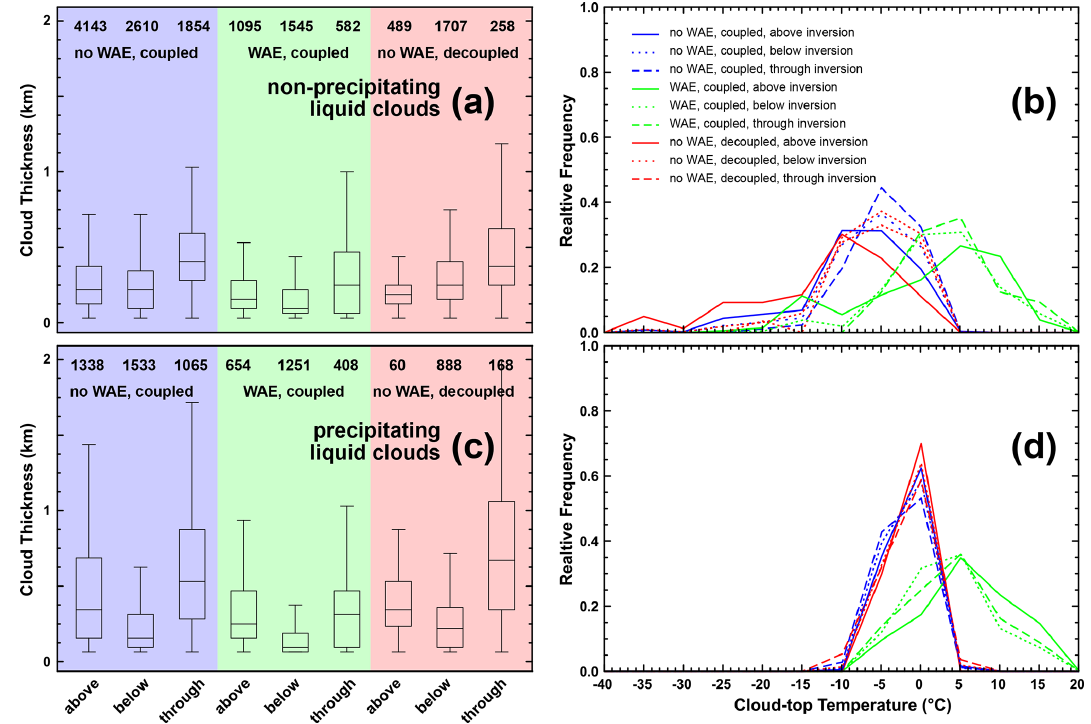
Figure 9. Statistics on the geometrical thickness (a, c) and the frequency distribution of cloud-top temperature (b, d) of non-precipitating (a, b) and precipitating (c, d) liquid clouds observed for different PBL structure, temperature in the free troposphere, and location with respect to the main inversion: non-WAEs with coupled PBL (blue), non-WAEs with decoupled PBL (red), and WAEs with coupled PBL (green). The different boxes (a, b) and lines in (c) and (d) refer to clouds with cloud base above the inversion (above), to clouds with cloud top below the inversion (below), or to clouds with cloud base below the inversion and cloud top above the inversion (through). Numbers in (a) and (b) refer to the number of Cloudnet profiles per category. Categories with fewer than 100 profiles have been omitted; this includes all cases of decoupled PBL during